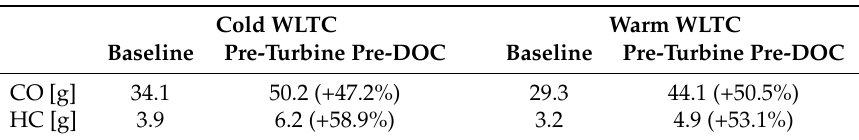
Table 4. Cumulative engine-out CO and HC emission in cold and warm WLTCs with baseline ATS and pre-turbine pre-DOC configurations.